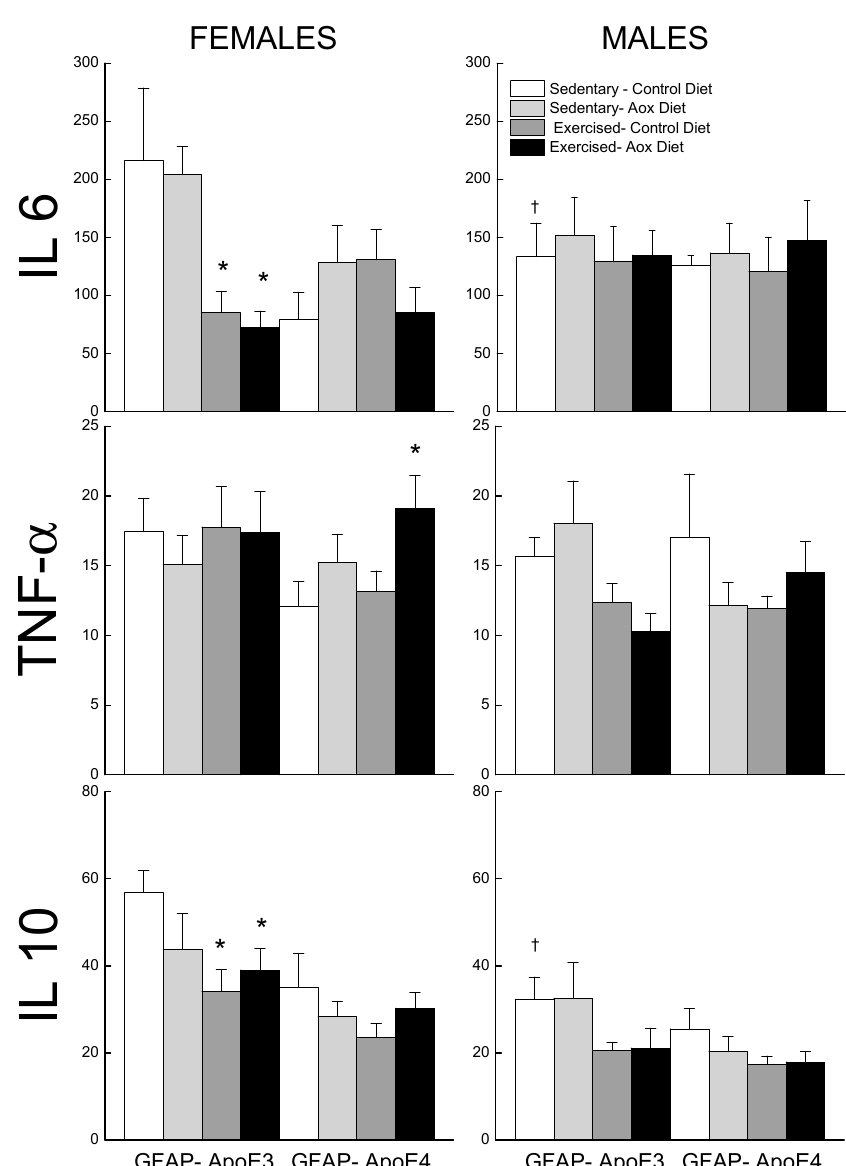
Figure6. EffectofexerciseandantioxidantsonmarkersofinflammationinmaleandfemaleGFAP-ApoE3 Figure 6. Effect of exercise and antioxidants on markers of inflammation in male and female GFAP- andGFAP-ApoE4mice. Eachvaluerepresentsmean ± SEM, n = 5–9. * p < 0.05vs. sex-andstrain-matched ApoE3 and GFAP-ApoE4 mice. Each value represents mean ± SEM, n = 5–9. * p < 0.05 vs. sex- and Sed-Con groups; † p < 0.05 comparing strain-matched Sed-Con males and strain-matched Sed-Con groups; † p < 0.05 comparing strain-matched Sed-Con males and females.